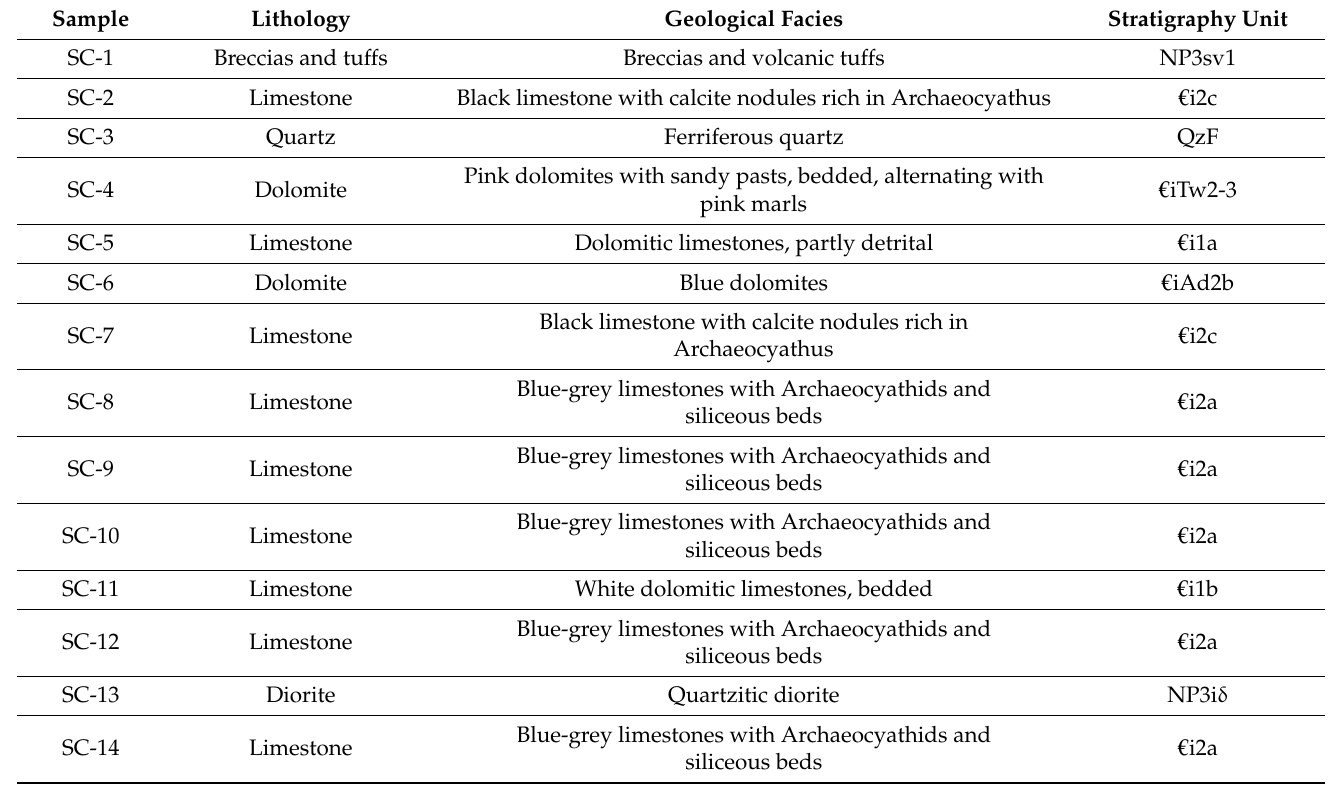
Table 1. Geological formations of samples.